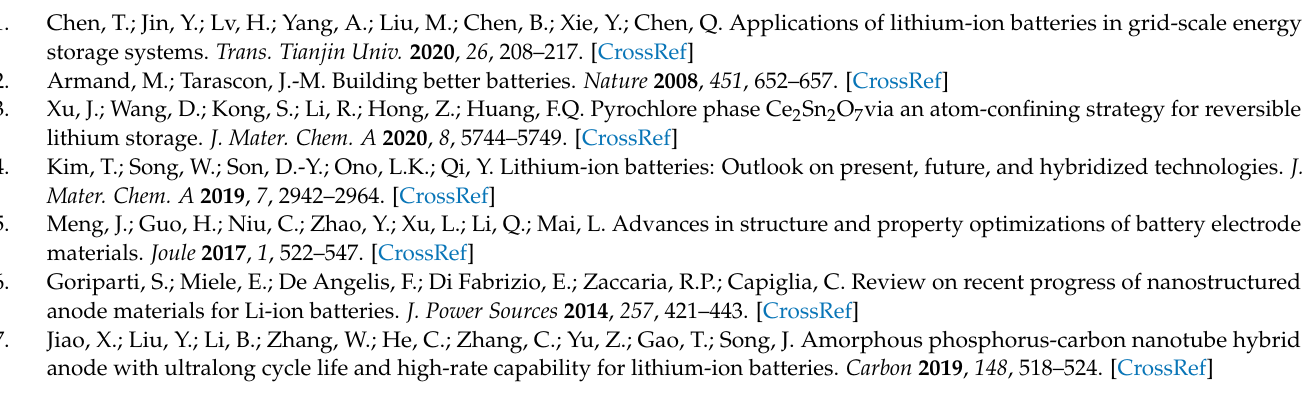
InSb_PVDF; Figure S3: SEM images of (a and b) InSb_PAA, (c and d) InSb_PVDF binder at different magnification; Figure S4: CV curves of InSb_PVDF from first to fifth cycle; Figure S5: DCP of InSb_PAA during 140 cycles measured at 100 mA · g − 1 : (a) 1 − 60 cycle, (b) 80 − 140 cycle. Enlarged view of (c) reduction peak and (d) oxidation peak; Figure S6: (a) DCP of InSb_PAA during initial 60 cycles measured at 500 mA · g − 1 . Enlarged view of (b) oxidation peak and (c) reduction peak; Figure S7: (a) DCP of InSb_PAA from 60 th to 100 th cycle measured at 500 mA · g − 1 . Enlarged view of (b) oxidation peak and (c) reduction peak; Figure S8: EDX spectrum of synthesized InSb–C; Figure S9: DCP profiles of InSb–C_PAA electrodes at current density of (a) 100 mA · g − 1 during 140 cycles and (b) 500 mA · g − 1 during 300 cycles; Figure S10: Coulombic efficieny of InSb_PAA, InSb_PVDF, and InSb–C_PAA at current density of (a) 100 and (b) 500 mA · g − 1 ; Figure S11: Cyclic performance of InSb-C_PAA at 15 A · g − 1 and 20 A · g − 1 ; Table S1: Crystallite size of InSb calculated using Scherrer equation; Table S2: Coulombic efficiency variation of InSb_PAA at various cycle numbers measured at 100 mA · g − 1 ; Table S3: Coulombic efficiency variation of InSb_PAA at various cycle numbers measured at 500 mA · g − 1 ; Table S4: Calculation of capacity contribution of InSb and C in the InSb-C composite; Table S5: Calculation of theoretical capacity of InSb and InSb-C; Table S6: Coulombic efficiency of InSb_PAA, InSb_PVDF, and InSb-C_PAA at current density of 100 mA · g − 1 for initial 10 cycles; Table S7: Coulombic efficiency of InSb_PAA, InSb_PVDF, and InSb–C_PAA at current density of 500 mA · g − 1 for initial 10 cycles; Table S8: The charge-transfer resistance (R ct ) of InSb_PAA, InSb_PVDF,